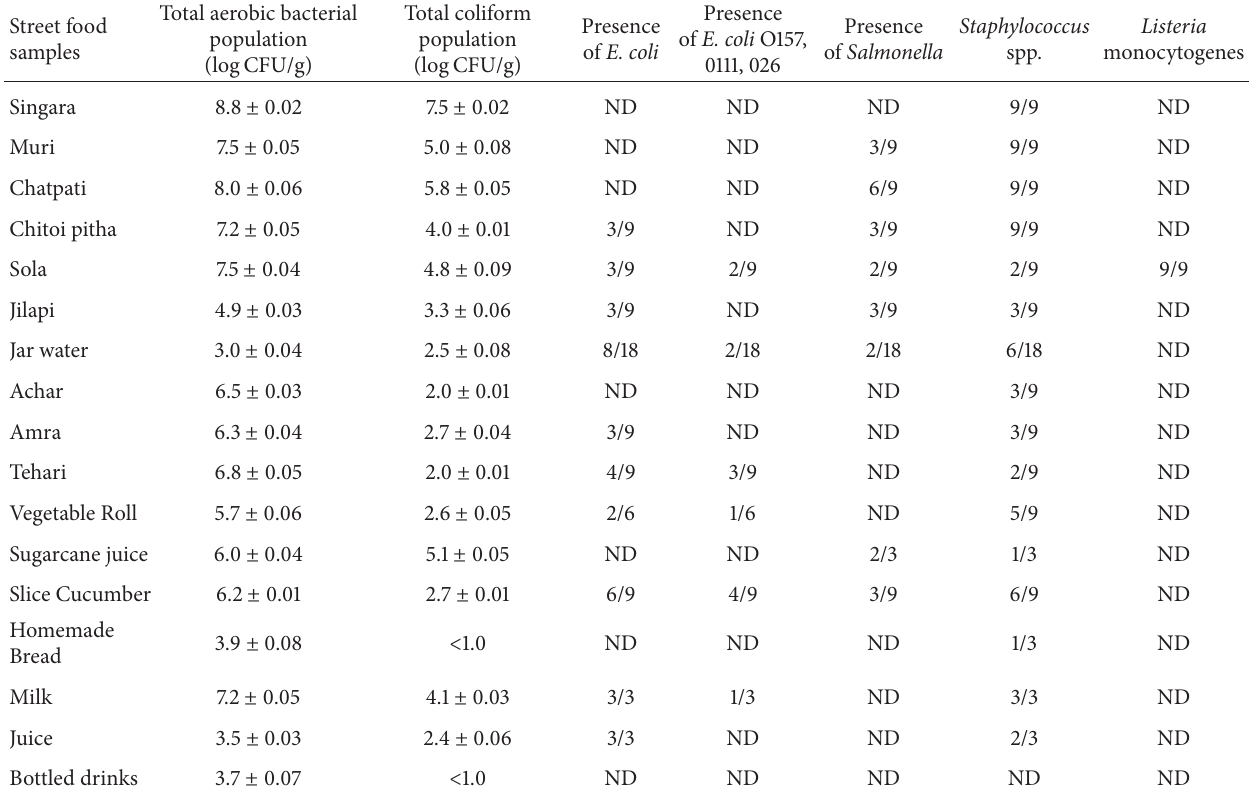
Table 2: Total aerobic bacterial and total coliform population and presence of different pathogens in the street food samples of Dhaka city. Street food